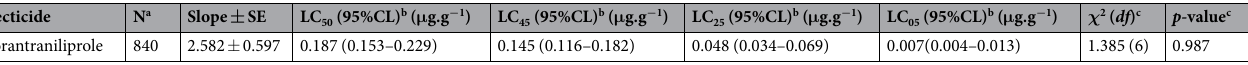
Table 1. Toxicity of chlorantraniliprole to 3rd-instar larvae of Agrotis ipsilon. a Number of larvae. b 95% confidence limits. c Chi-square value ( χ 2 ), degrees of freedom ( df ), and p -value as calculated by probit analysis with SPSS